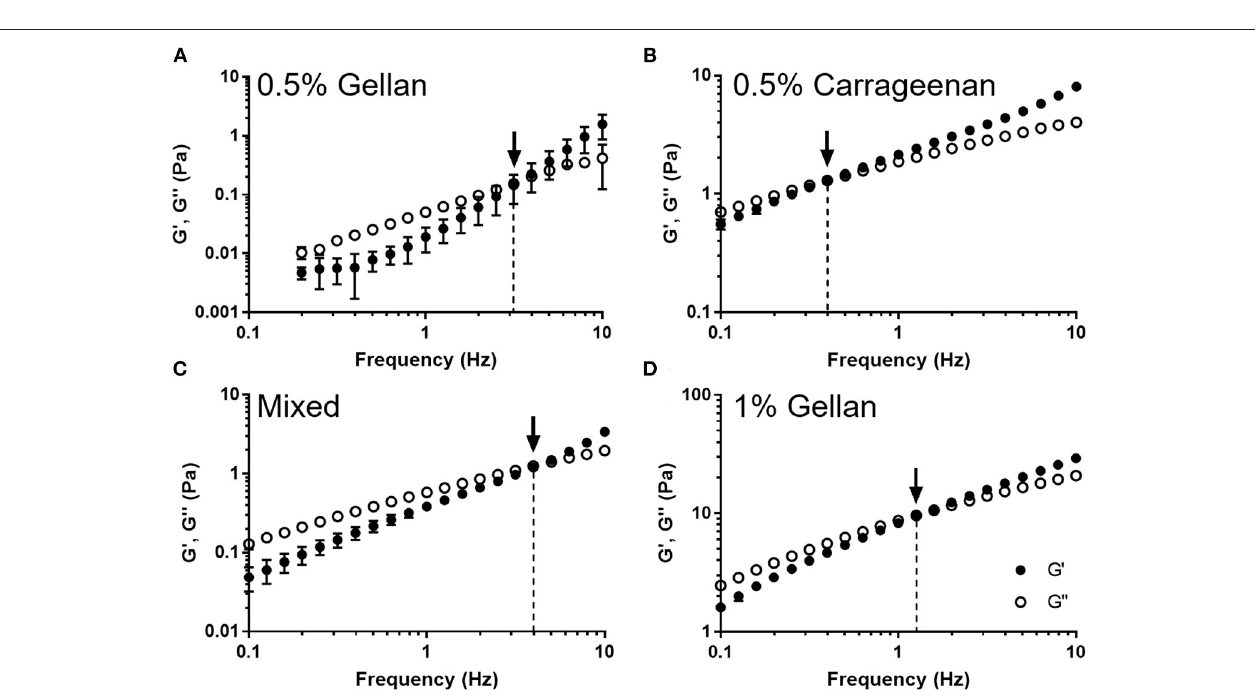
FIGURE 4 | The storage modulus (G ′ ) and loss modulus (G ′′ ) as a function of frequency for (A) 0.5% gellan, (B) 0.5% carrageenan, (C) the mixed system, and (D) 1% gellan. Arrows indicate the point at which G ′ = G ′′ , and the dashed lines show the frequency at which this occurs. Graphs show mean ± SD ( n = 3).